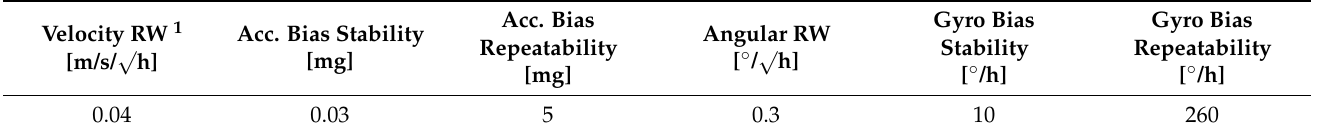
Table 1. IMU parameters [37].